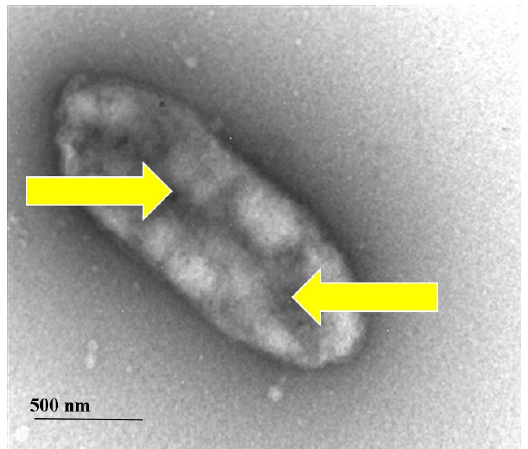
Figure 9. The TEM image of Pseudomonas aeruginosa was irradiated at 785 nm for 10 min. The figure evident harm to the bacterial cell, as seen with arrows [67]. Reprinted with permission from ref. [67]. Copyright 2011 Wiley Interdisciplinary Reviews—Nanomedicine and